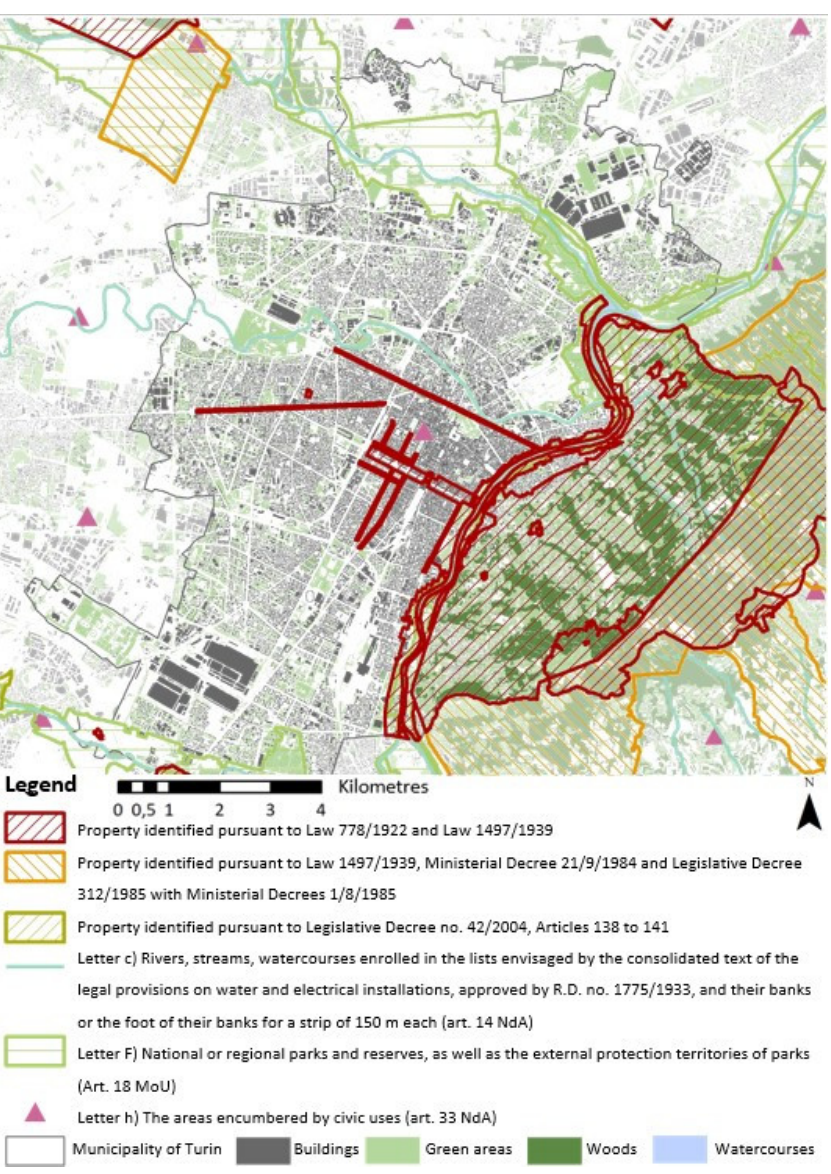
Figure 4. Landscape assets of the regional landscape plan [29]. Table 3. Landscape Assets of the City of Turin [29] .